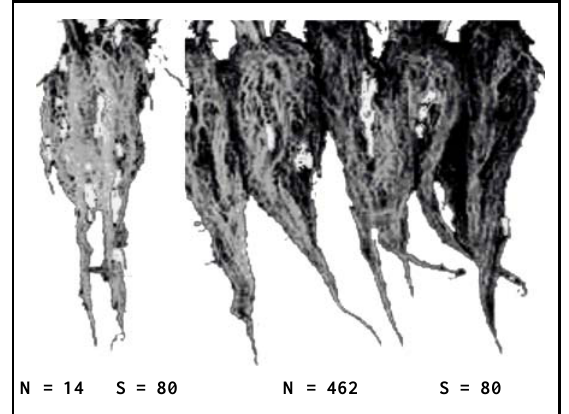
Figura 3. Sistema radicular do capim-Marandu submetido a doses de nitrogênio (alta e baixa), em combinação com uma dose de enxofre, aos 79 dias do transplantio.